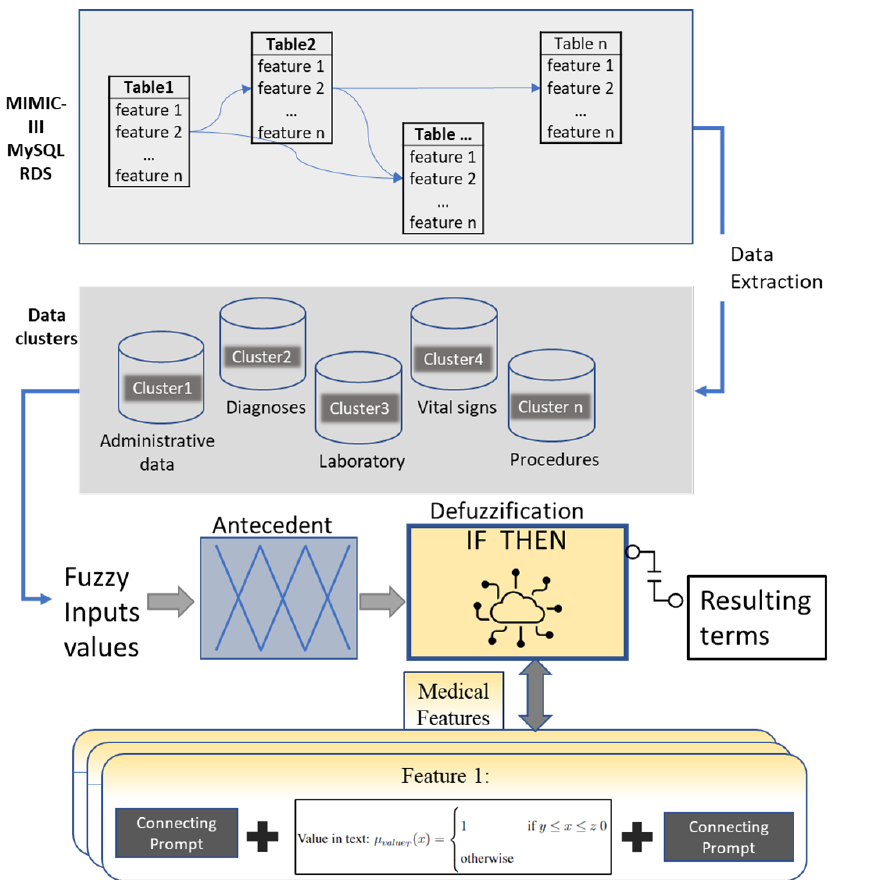
Figure 1. Summary of the data extraction and synthetic narratives of the generation